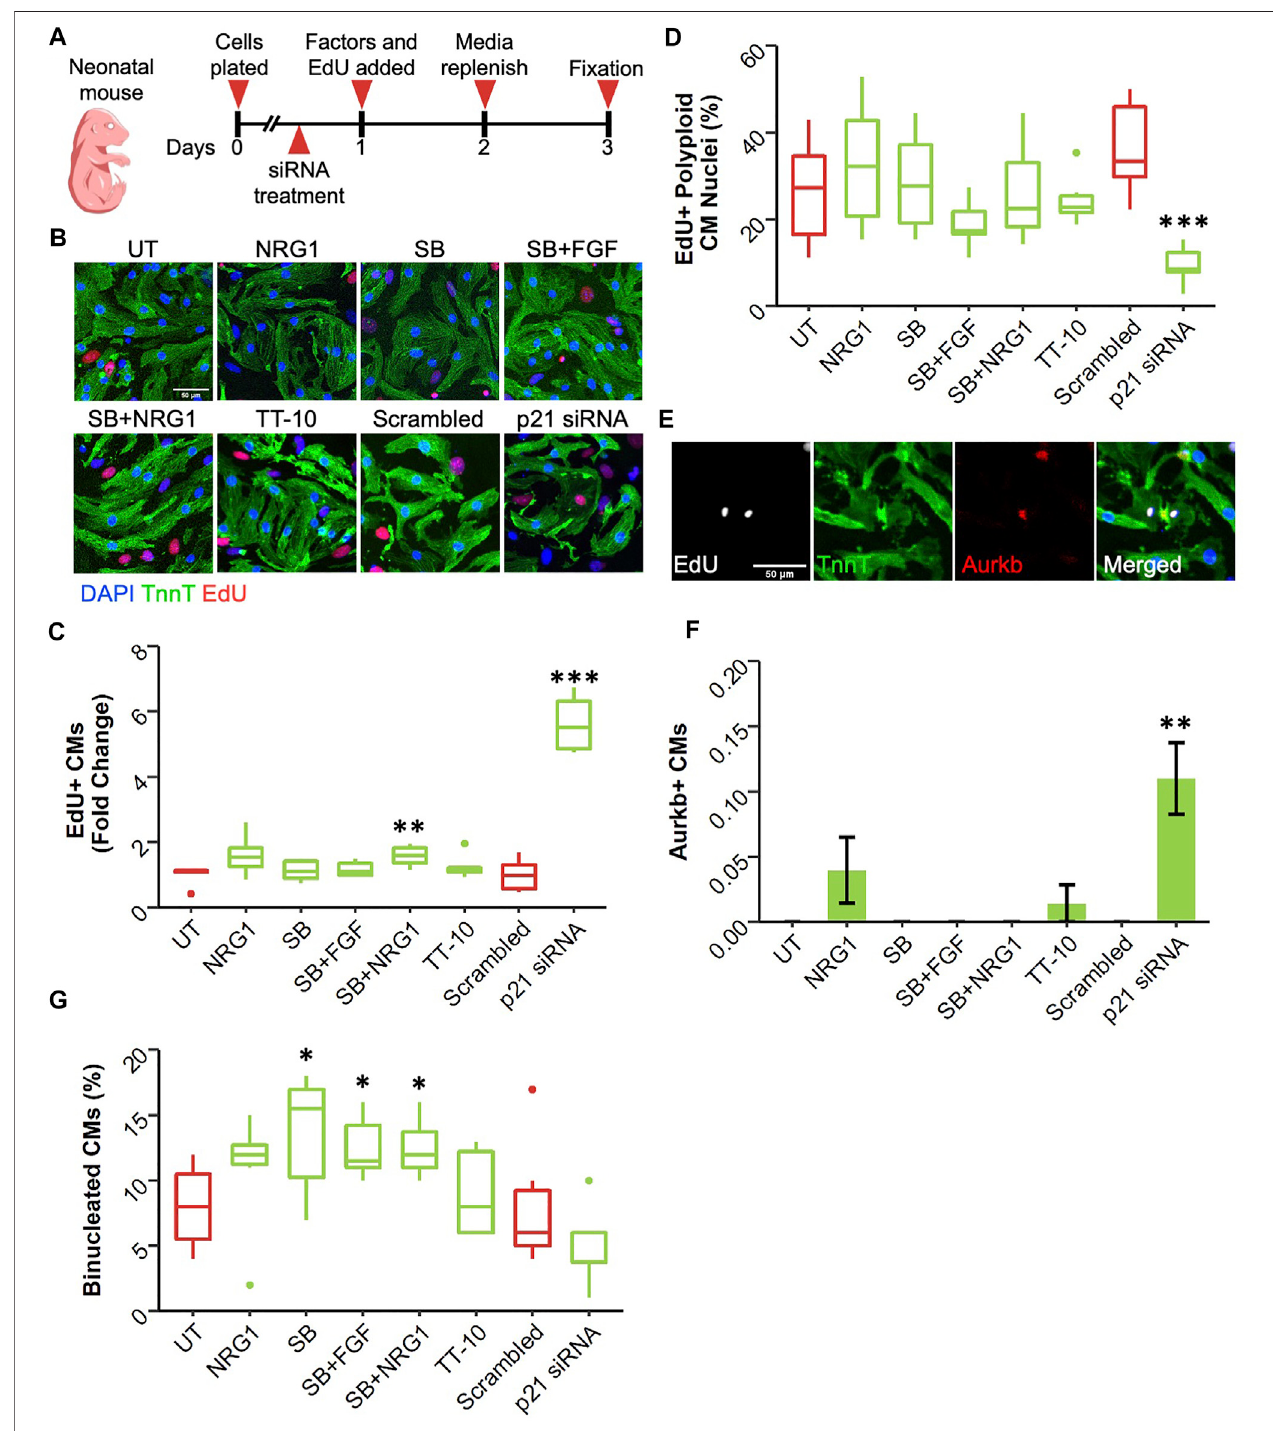
FIGURE 5 | Effect of proliferative stimuli on neonatal mouse cardiomyocytes. (A) Experimental outline. Neonatal mouse cardiomyocytes were isolated and plated on Day 0, 36 h later siRNAs and 48 h later proliferative stimuli were added. Edu was added along with proliferative stimuli and was present for the last 48h of culture. (B) Representative images of neonatal mouse cardiomyocytes stained for TnnT (green), EdU (Red) and DAPI (blue) (scalebar = 50 µm) (C) Quanti fi cation of Fold Change in relativeEdU+CMnuclei( n =6foreachgroup,* p < 0.05,*** p < 0.001) (D) Quanti fi cationofEdU+polyploid(4n+)nucleibasedonDAPIhistograms( n =6,* p < 0.05, *** p < 0.001) (E) RepresentativeimageofAurkb+cardiomyocyteintheprocessofundergoingcytokinesis (F) AbundanceofAurkb+CMsrelativetototalnumberofCMs after treatments ( n = 6 for each group) (G) Percentage of binucleated CMs at the end of culturing period ( n = 6 for each group).